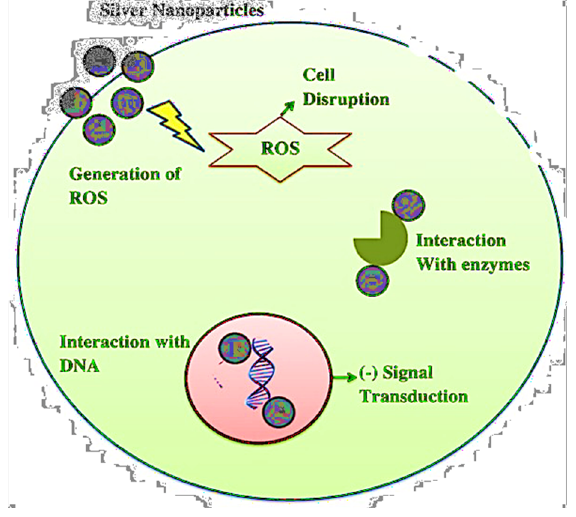
Figure 5. The modes of action of AgNPs composite against